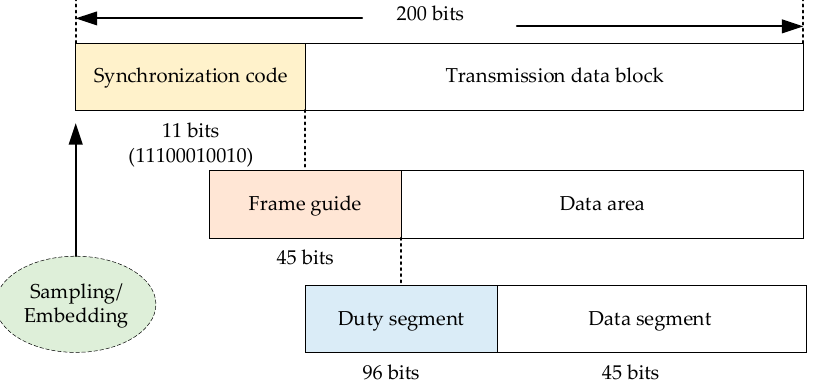
Figure 3. Inter-satellite transmission subframe structure.